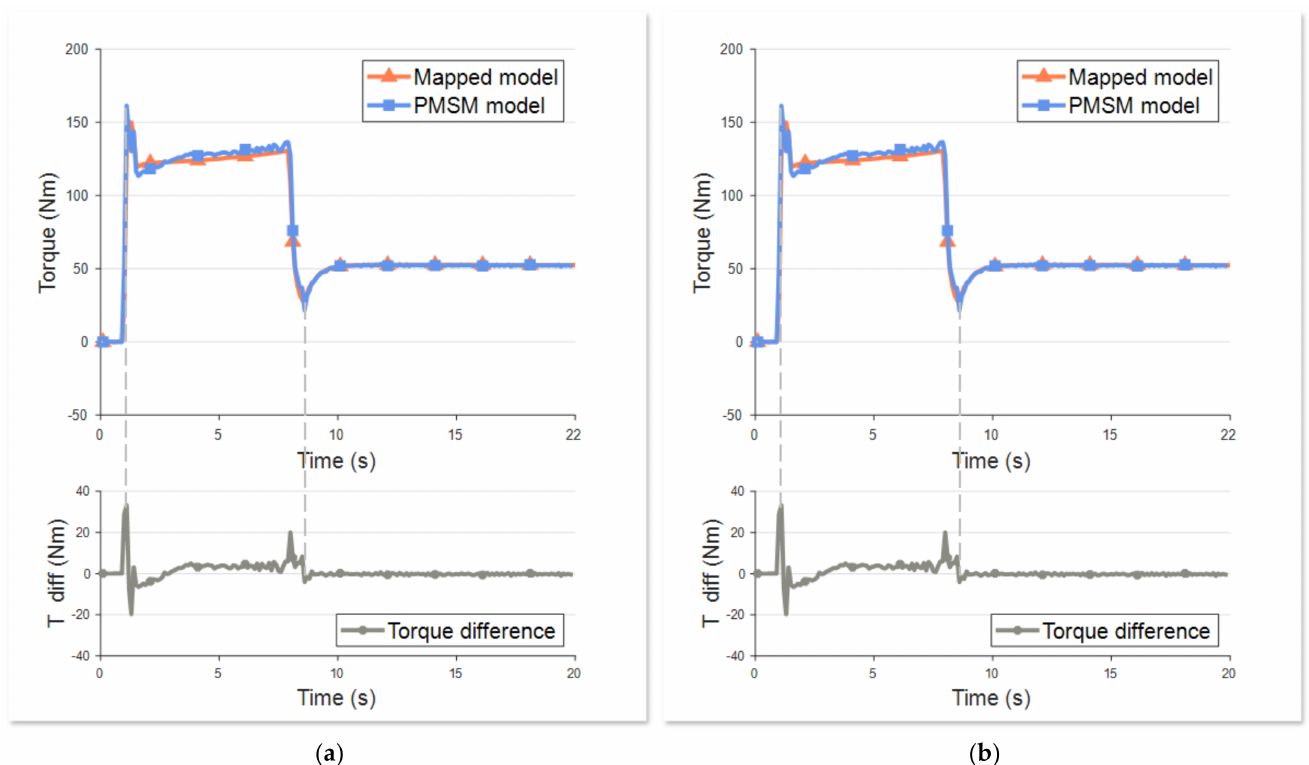
Figure 10. Torque and Rotation Speed in Different Models. ( a ) Torque. ( b ) Rotation